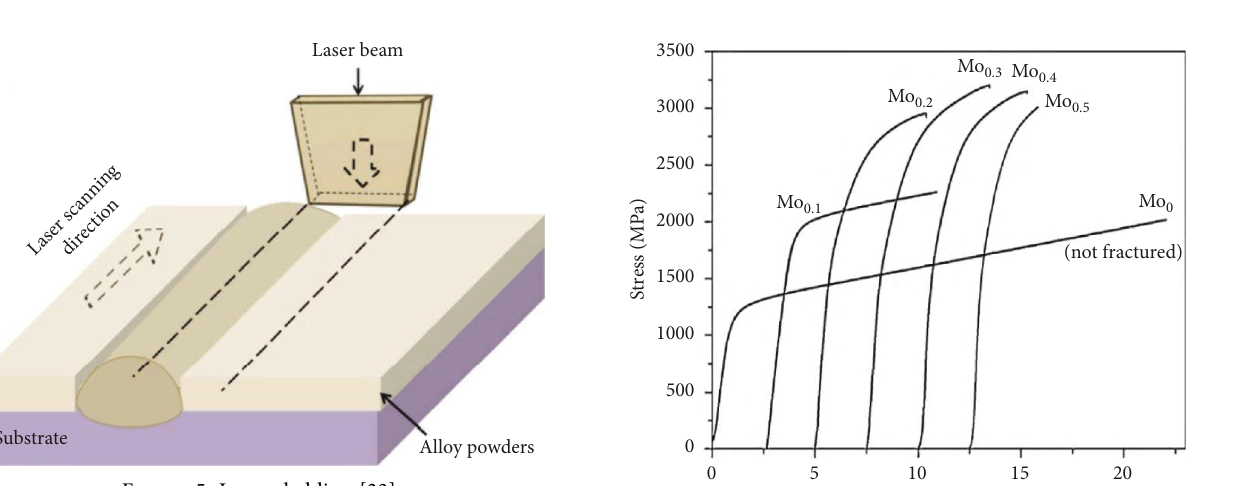
Figure 4: Plasma spray technique